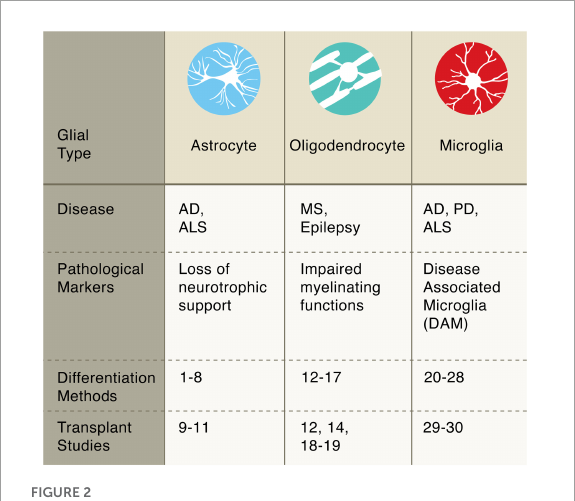
FIGURE2 Pluripotent stem cell differentiation strategies for producing